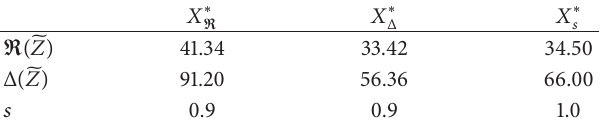
Table 2: The pay-off matrix of ( EP 2)